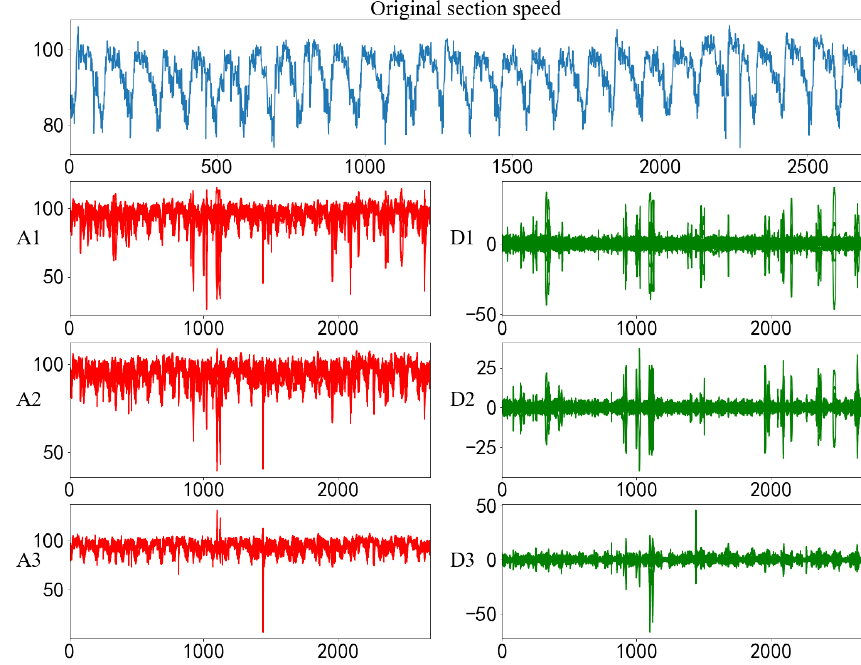
Figure 7. Section speed decomposition